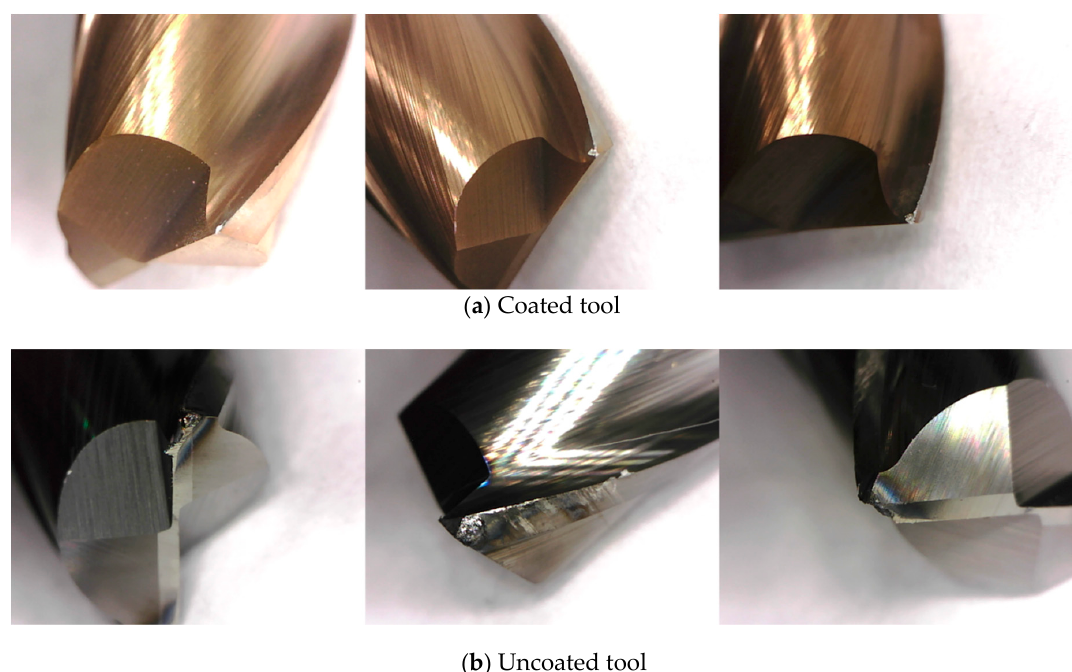
Figure 8. The tool wear of the coated tool and uncoated tool. ( a ) Coated tool; ( b ) Uncoated tool.